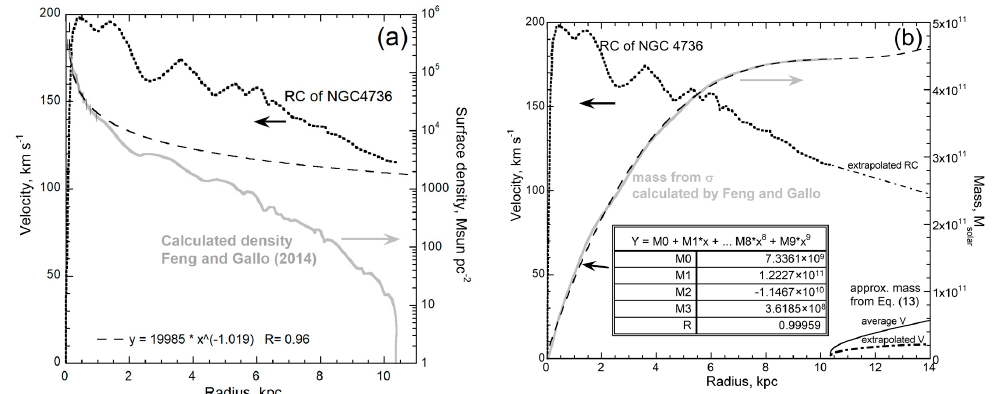
Figure 14. Inverse analysis of NGC 4736 of Feng and Gallo [64], based on measured RC of De Blok et al. [53], shown as a black dotted line: ( a ) Results for σ from numerical evaluation of (24) by [64]. Dashed line = least squares fit below 1 kpc, which equals 1 / r within the uncertainty of the selected cuto ff ; ( b ) Mass obtained form (25), which integration smooths σ . Black dashed line = a third order polynomial obtained from a least squares fit. Heavy lines in the lower right corner show mass computed for a thin, constant density disk from (13), using two approximations for RC. Average v = 159 km s − 1 . Thin dash-dotted line shows the extrapolation used. Equation (13) has a singularity in v at r = a , but merges with the point mass approximation at very large r